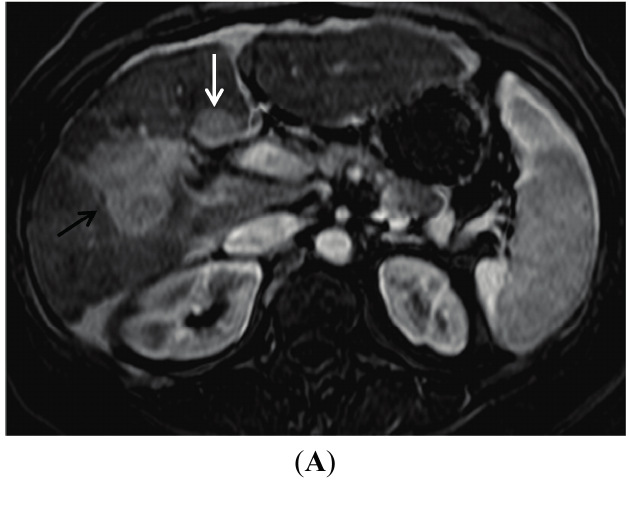
Figure 3. The importance of gadoxetic acid for visualization of small and/or ill-defined HCC. ( A ) A subtle area of vague enhancement (arrow) is seen in the late arterial phase sequence in this patient with end-stage liver disease; ( B ) This area (arrow) on the portal venous phase remains ill-defined and could easily be missed; ( C ) The 20-min hepatobiliary phase of this gadoxetic acid contrast enhanced exam demonstrates a well-defined area of low signal intensity. This image allows critical review of the corresponding area on the earlier sequences to now appreciate the minimal hyperenhancement in the arterial phase and the very subtle washout of the portal venous phase to suggest a diagnosis of